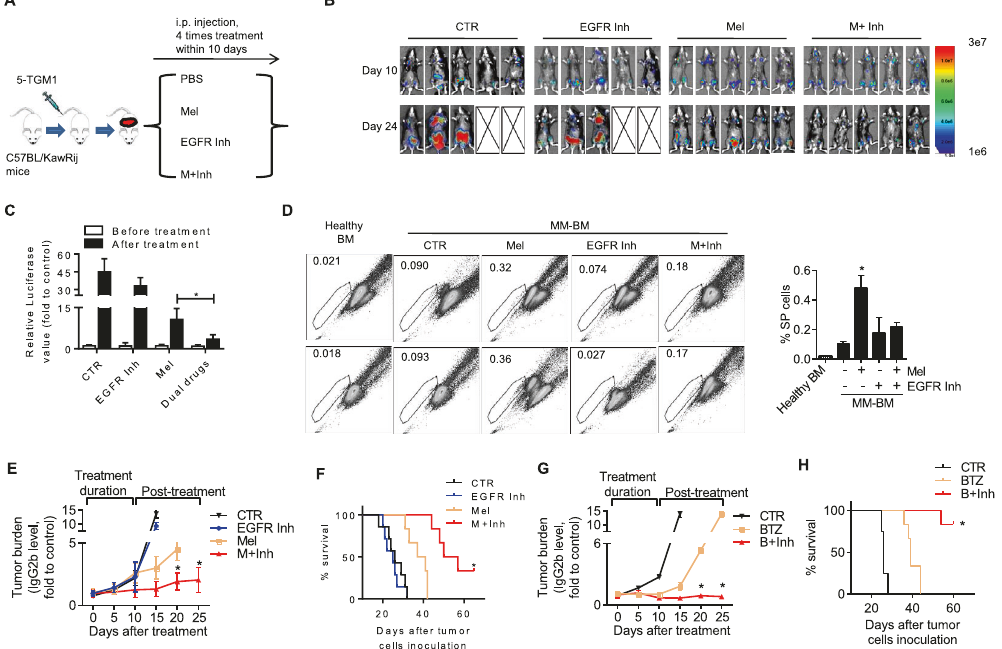
Fig. 6 EGFR-targeting therapy attenuates side population conferred myeloma chemoresistance in vivo. A Scheme graph showing the animal study to evaluate the ef fi cacy of the combination therapy (Mel and EGFR inhibitor) in vivo. The mice were treated by intraperitoneal injection of melphalan (60 μ g/mouse per time, 4 times within 10 days) or ge fi tinib (500 μ g/mouse per time, 4 times within 10 days), or a combination of both. Each group contained 8 mice. B Tumor-bearing mice were subjected to in vivo bioluminescent imaging (IVIS) before and after treatment. Five out of seven representative results are shown. C The relative luciferase activity of IVIS was calculated. D The tumor- bearing mice were treated twice as described above. Then, mice BM cells were analyzed by Hoechst staining for MM SP in vivo. Two out of three representative results are shown in the left panel, and result quanti fi cation is shown in the right panel. E Tumor burden was evaluated by circulating IgG2b. F Treatment ef fi cacy was evaluated by mouse survival. G MM tumor-bearing mice were treated by intraperitoneal injection of PBS, bortezomib (15 μ g/mouse per time, 4 times within 10 days), or a combination of bortezomib and ge fi tinib (500 μ g/mouse per time, 4 times within 10 days). The PBS group contained 4 mice; the other treated group each contained 6 mice. Tumor burden was evaluated by circulating IgG2b. H Treatment ef fi cacy was evaluated by mouse survival (* p <